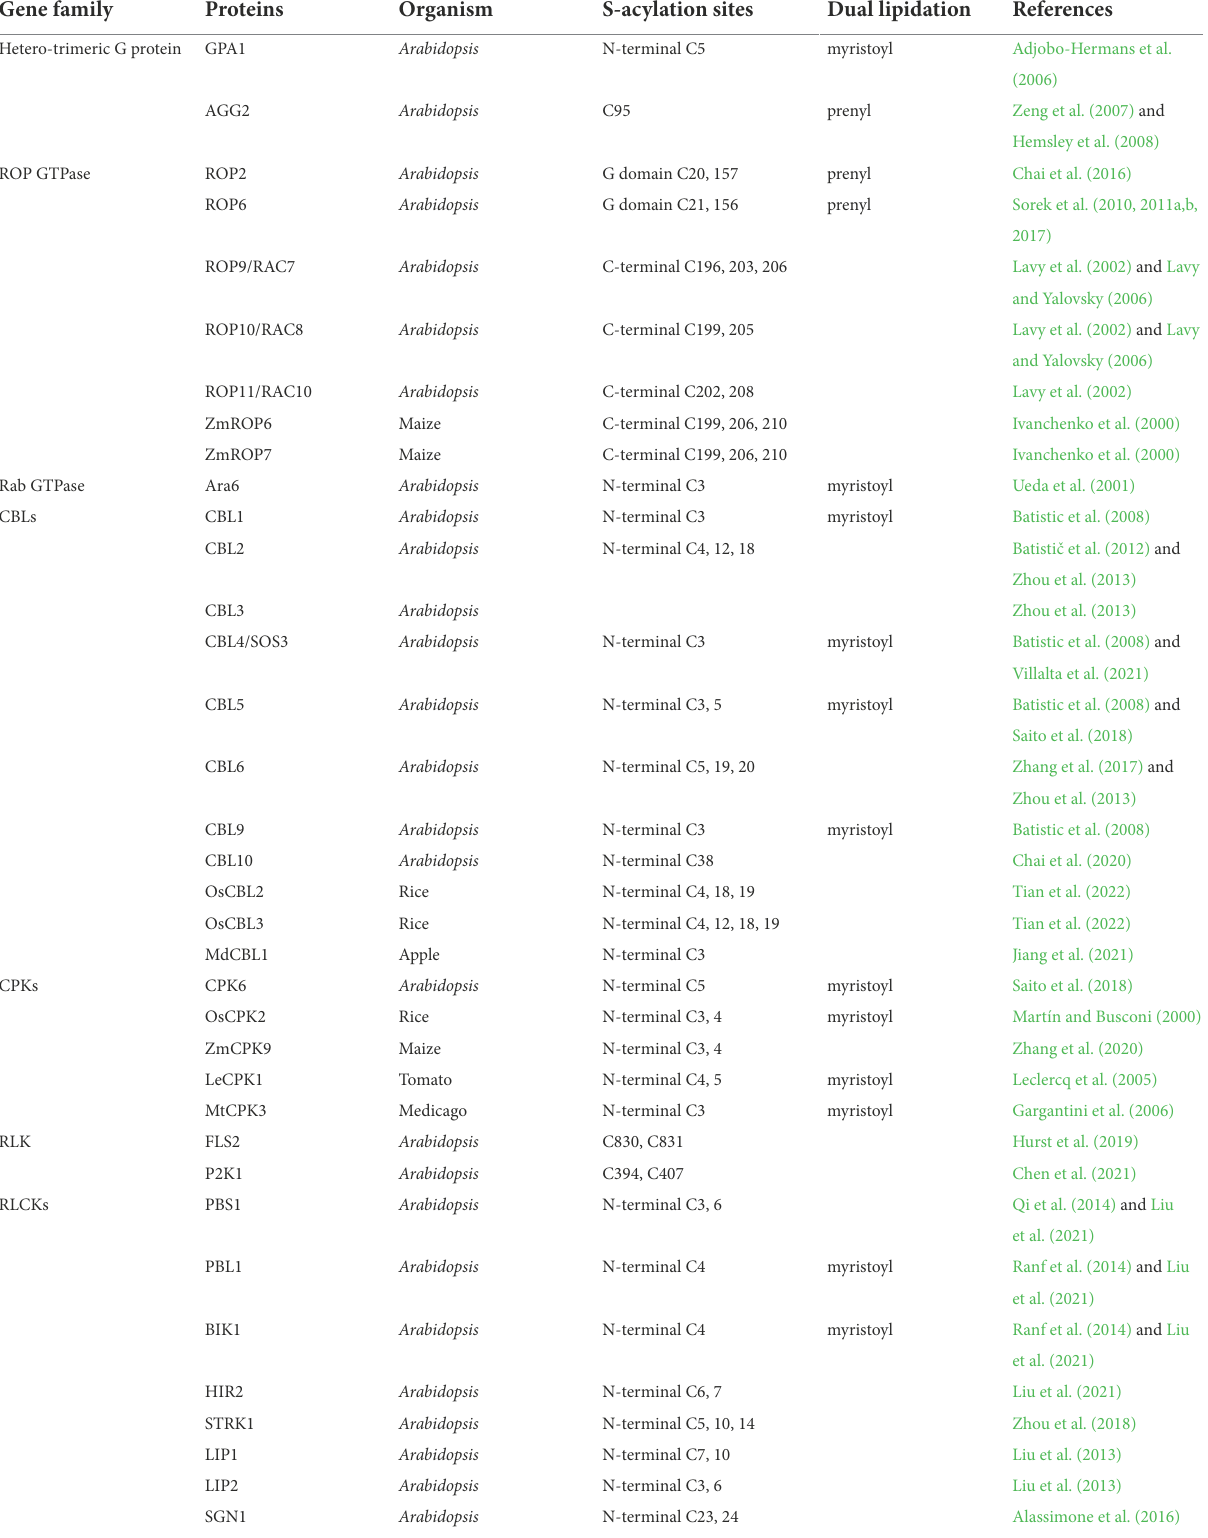
TABLE 1 Functionally characterized S-acylated proteins in